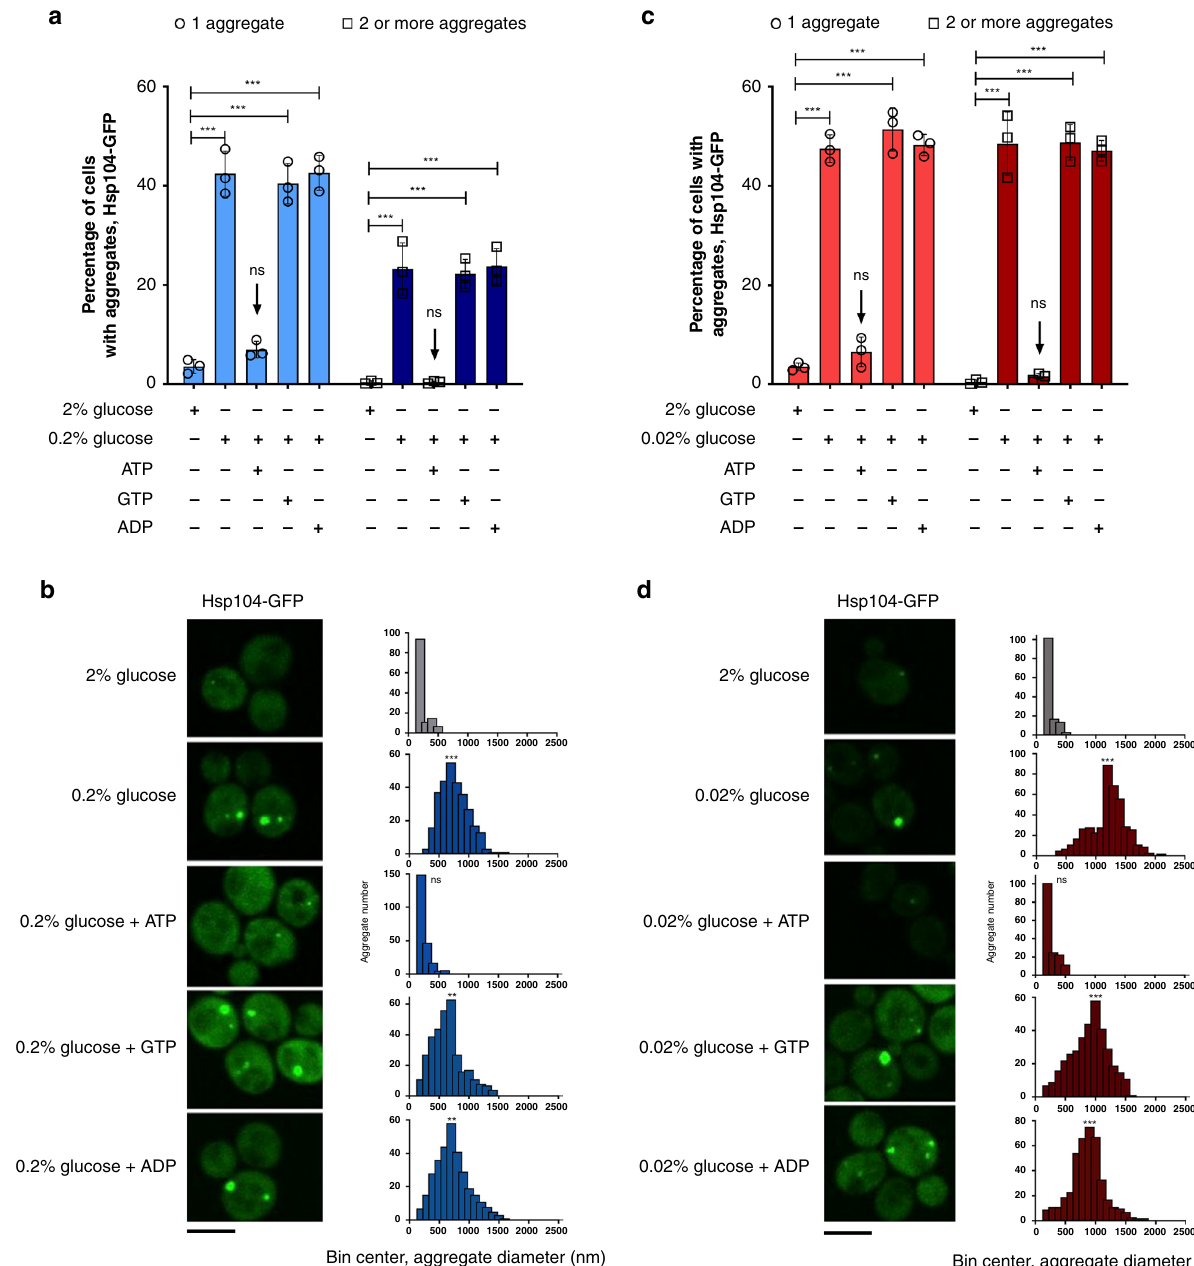
Fig. 1 ATP prevents protein aggregate accumulation during glucose starvation. a The percentage of cells bearing 1 (light blue) and 2 or more (dark blue) aggregates strongly increases during a 90-min starvation in 0.2% glucose. Treatment with ATP, but not GTP or ADP (all in the presence of DMSO), causes the fraction of cells bearing aggregates to return to levels comparable to control. b Mean aggregate diameter shifts to larger sizes during starvation in 0.2% glucose. The addition of ATP, but not GTP or ADP (all in the presence of DMSO), results in aggregates reverting to the sizes observed in control conditions. c The percentage of cells bearing 1 (light red) and 2 or more (dark red) aggregates strongly increases during a 90-min starvation in 0.02% glucose. Treatment with ATP, but not GTP or ADP (all in the presence of DMSO), causes the fraction of cells bearing aggregates to return to levels comparable to control. d Mean aggregate diameter shifts to larger sizes during starvation in 0.02% glucose. The addition of ATP, but not GTP or ADP, results in aggregates reverting to the sizes observed in control conditions. In panels a and c , n = 1200 cells were screened for aggregates starting from three independent exponential yeast cultures for each condition. Black arrows are pointing towards the starvation condition supplemented with ATP. Data are mean ± SD from at least three independent cultures, each performed in triplicate, and the means of technical replicates are represented as individual data points. *** p < 0.001; ** p < 0.01; * p < 0.05 (one-way ANOVA plus Tukey post hoc). In panels b and d the data represent binned values of individual aggregate diameters for N = 127, 297, 224, 330, and 320 aggregates from three independent exponential yeast cultures for each condition: 2% glucose, starvation, starvation + ATP, starvation + GTP, and starvation + ADP, respectively. The images are representative of three biological replicates, each in three technical replicates. Kolmogorov – Smirnov test was used to compare the statistical signi fi cance of the observed differences between each studied condition with the control (2% glucose) *** p < 0.001; ** p < 0.01; * p < 0.05. The black bar represents 8 µ